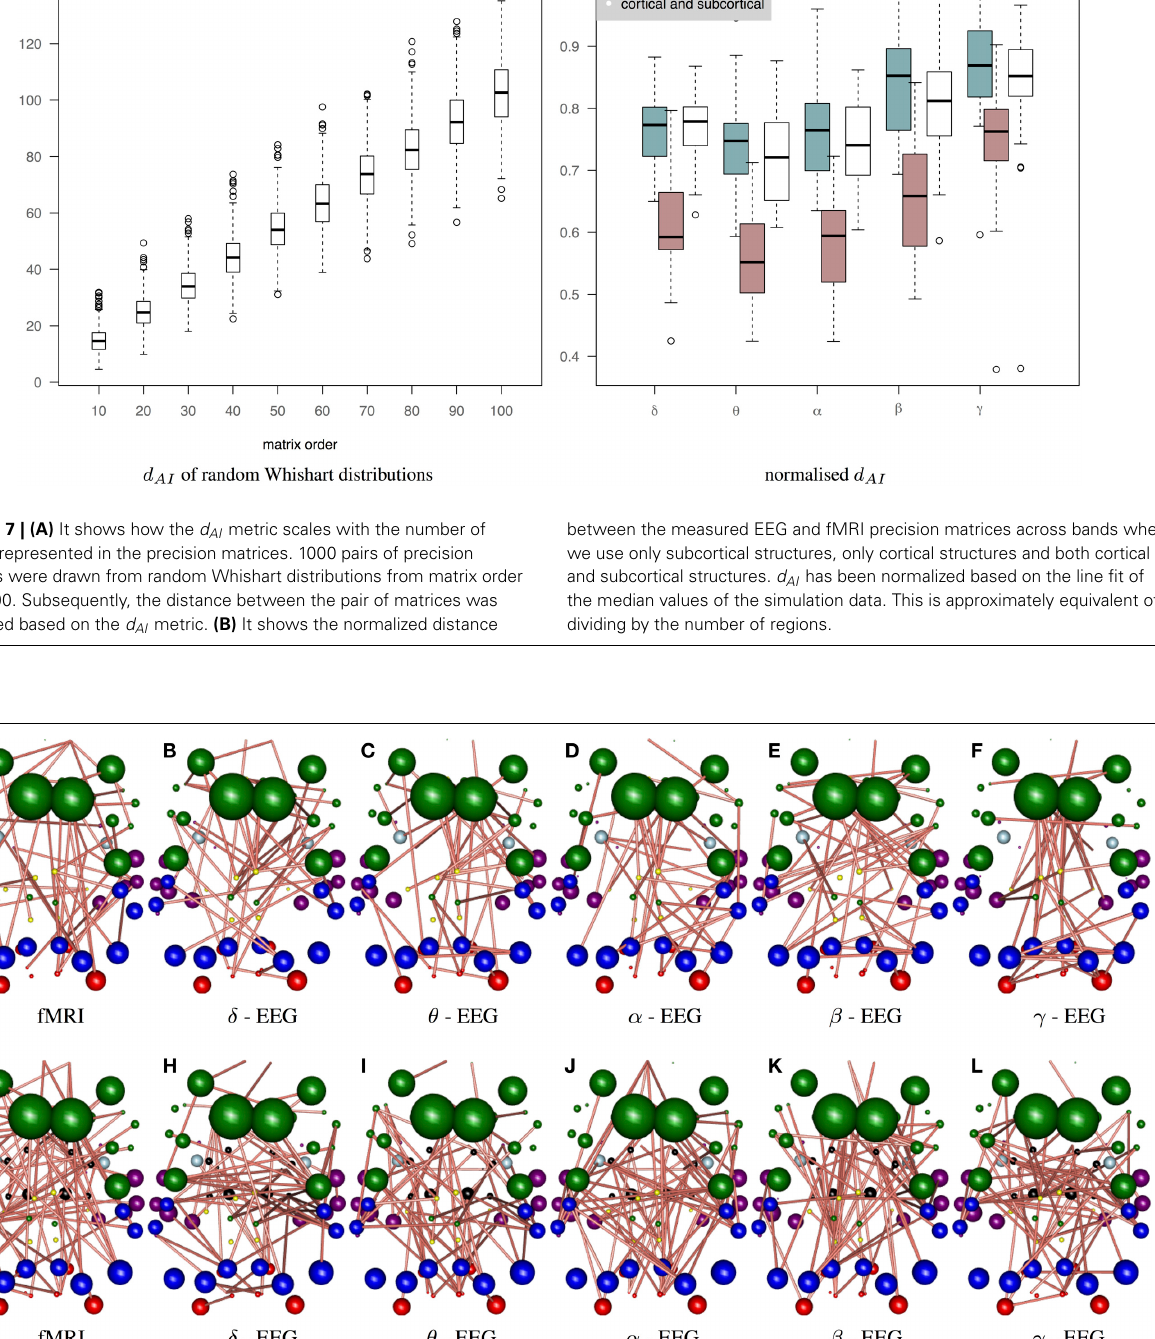
FIGURE 8 | Results derived from randomized Lasso for the WTS case. These reflect the 2% connections selected more often over all sCCA repetitions. (A–F) Shows results with the precision matrices